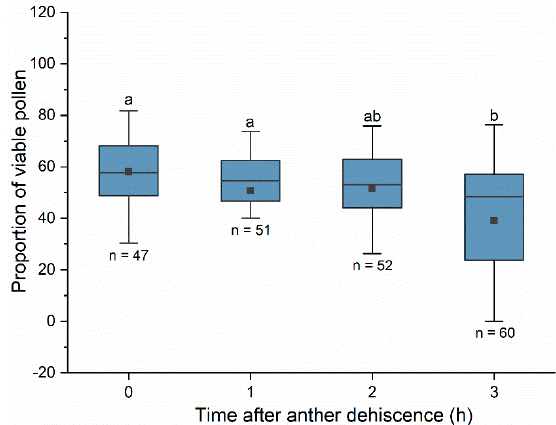
Figure 6. The proportion of viable pollen at different times after anther dehiscence. Pollen viability was tested using TTC. The difference in pollen viability at different times was compared using the Kruskal–Wallis test. Different letters indicate significant differences in pollen viability based on the Dunn–Bonferroni test at α = 0.05. Boxes indicate quartiles with the median marked as a horizontal line and the mean marked as a dot.